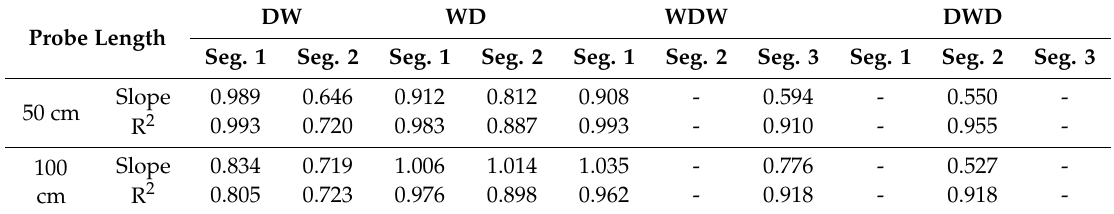
Figure 14. Difference between actual segment length and segment length estimated for each duration in the WDW treatment along; ( a ) SWC; ( b ) difference in SWC.